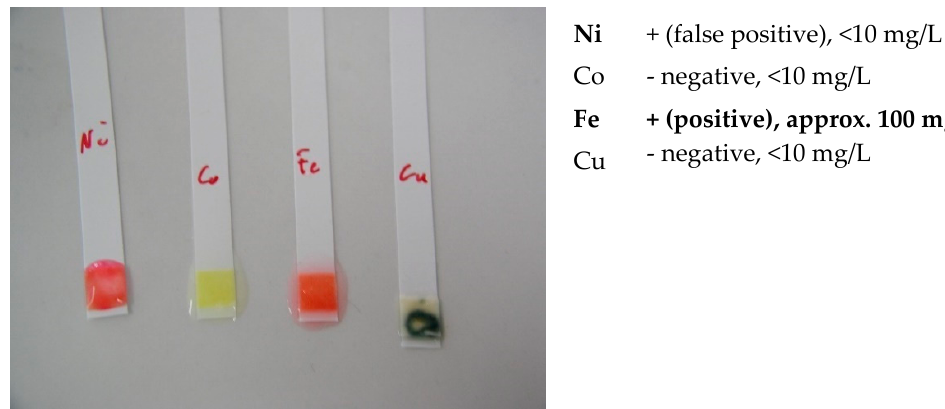
Figure 21. Screening tests. Black zirconia ceramic bracelet components E1 and E2.*Fe, in a concentration above 10 mg/l interferes with Ni.